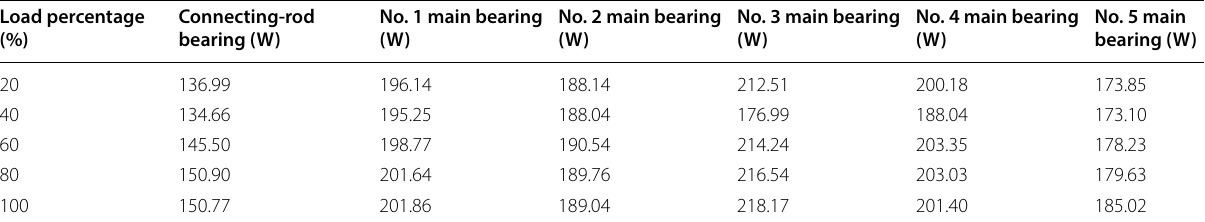
Table 9 Average friction power losses of connecting‑rod bearing and main bearings at 2200 r/min and different load